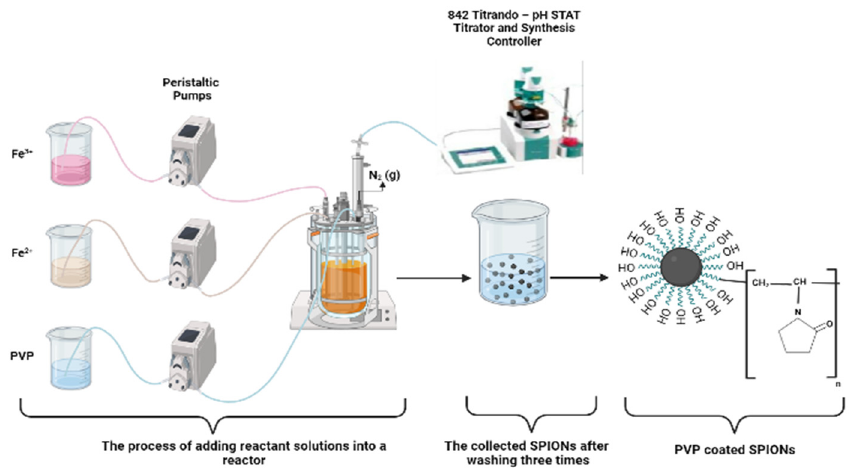
Figure 1. A schematic diagram showing the steps involved in the synthesis of bared and coated SPIONs by the co-precipitation method in a single SPIONs by the co-precipitation method in a single pot.